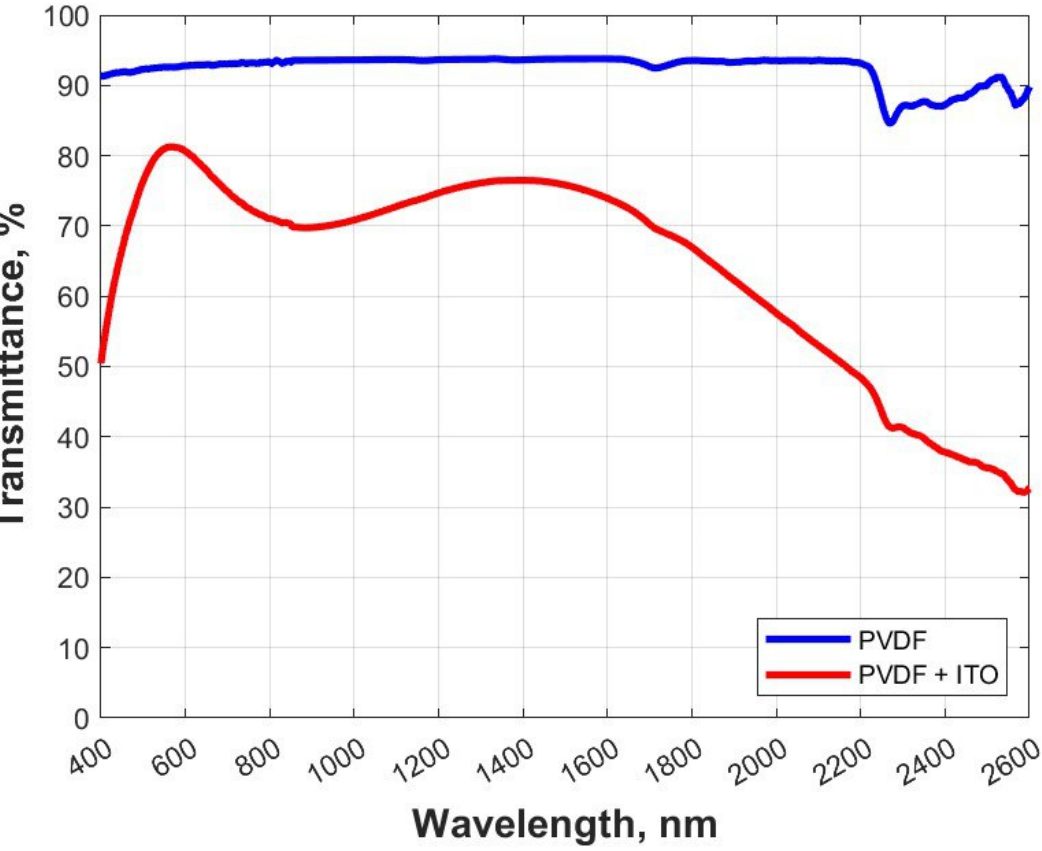
Figure 10. Transmi tt ance for PVDF and PVDF + ITO fi lms. Figure 10. Transmittance for PVDF and PVDF + ITO